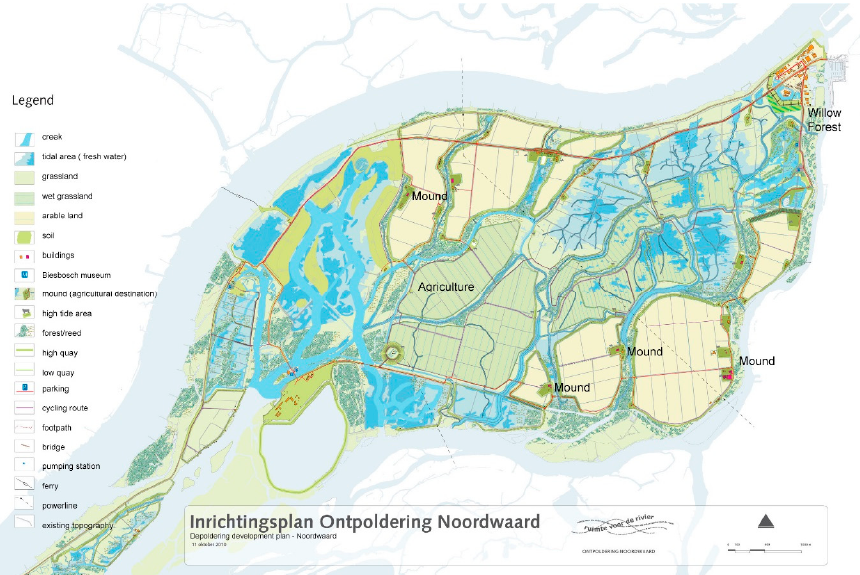
Figure 2. Masterplan of the depoldering of Noordwaard illustrating the water, agricultural areas and mounds where housing has been established. Image courtesy of Annika Hesselink and Rijkswaterstaat provided in Dutch (English translation of the legend by authors for the purposes of this paper).